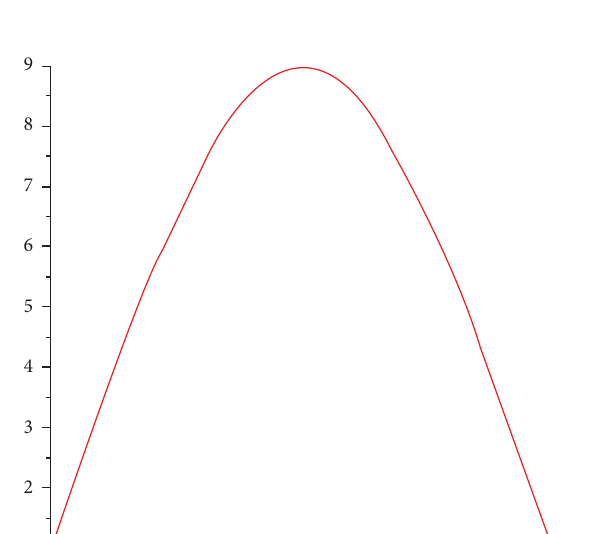
Figure 1: Convex function.